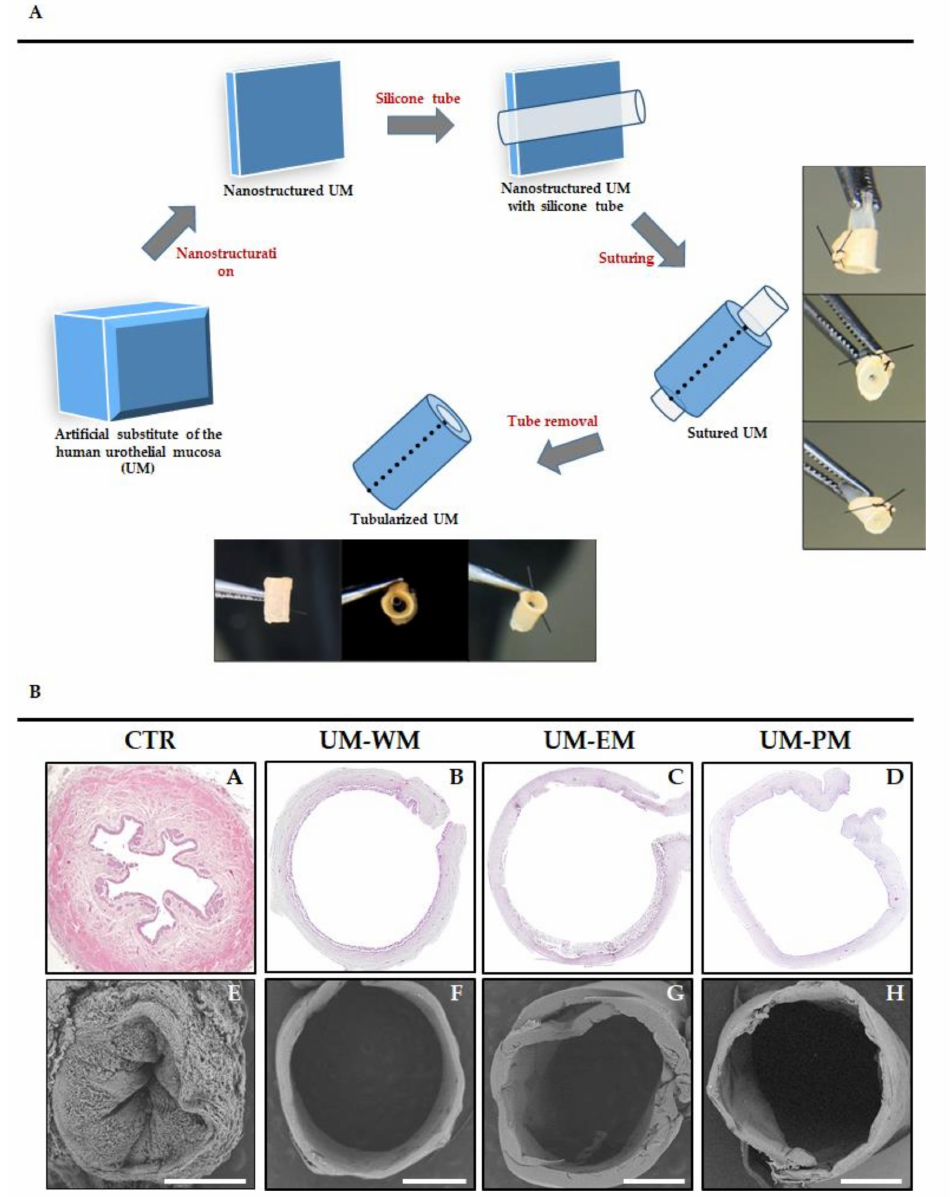
Figure 1. ( A ) Procedure used for the generation of tubularized heterotypical substitutes of the human urothelial mucosa (UM). ( B ) Low-magnification histological analysis of control human UM (CTR) and tubularized heterotypical substitutes of the human UM cultured with three different media (WM, EM and PM) and stained with hematoxylin-eosin ( A – D ) or analyzed with scanning electron microscopy ( E – H ). Scale bars: 1